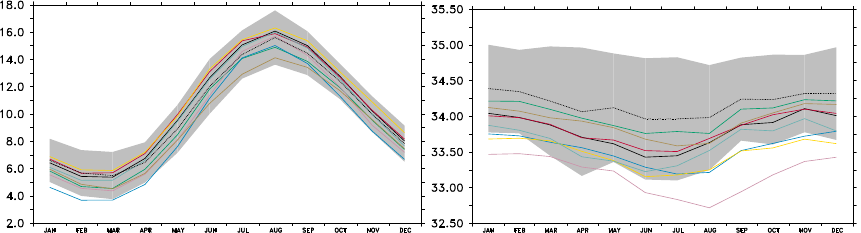
Figure 3. Climatological seasonal cycles averaged over the North Sea for SST ( ◦ C) ( left ) and sea surface salinity (SSS) (g/kg) ( right ) for different RCA4-NEMO experiments during period P0. The dotted, black line, and the shaded area are derived from the KNSC dataset. The shading indicates the 95% confidence limits. The black (light blue) lines apply to the coupled (ocean only) ERA40 hindcasts. The six other curves denote the results of the RCM driven with MPI-ESM-LR (red), EC-EARTH (green), GFDL-ESM2M (blue), HadGEM2-ES (yellow), IPSL-CM5A-MR (rose), ECHAM5 (olive), respectively.